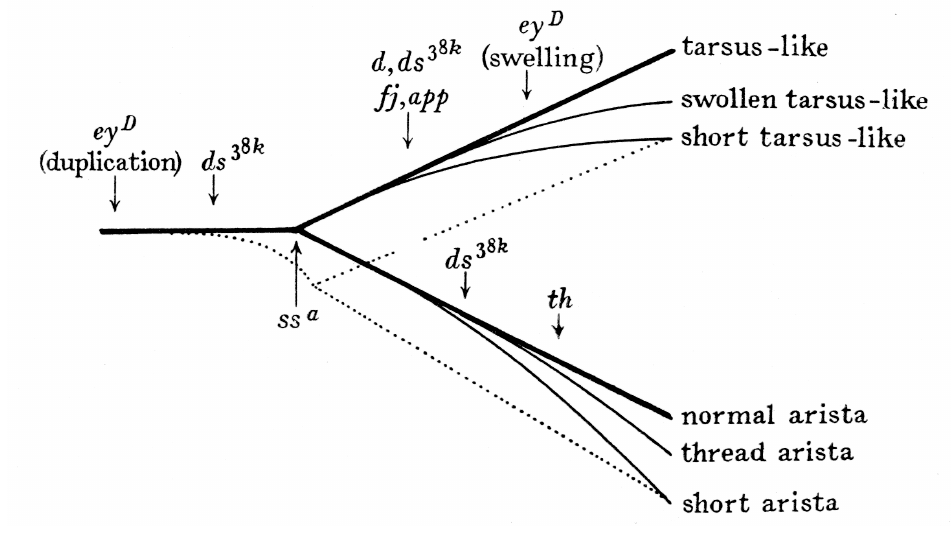
The Aristopedia Developmental Track System , from Conrad H. Waddington , Organizers and Genes (Cambridge, UK: Cambridge University Press, 1940), 83 (photo: